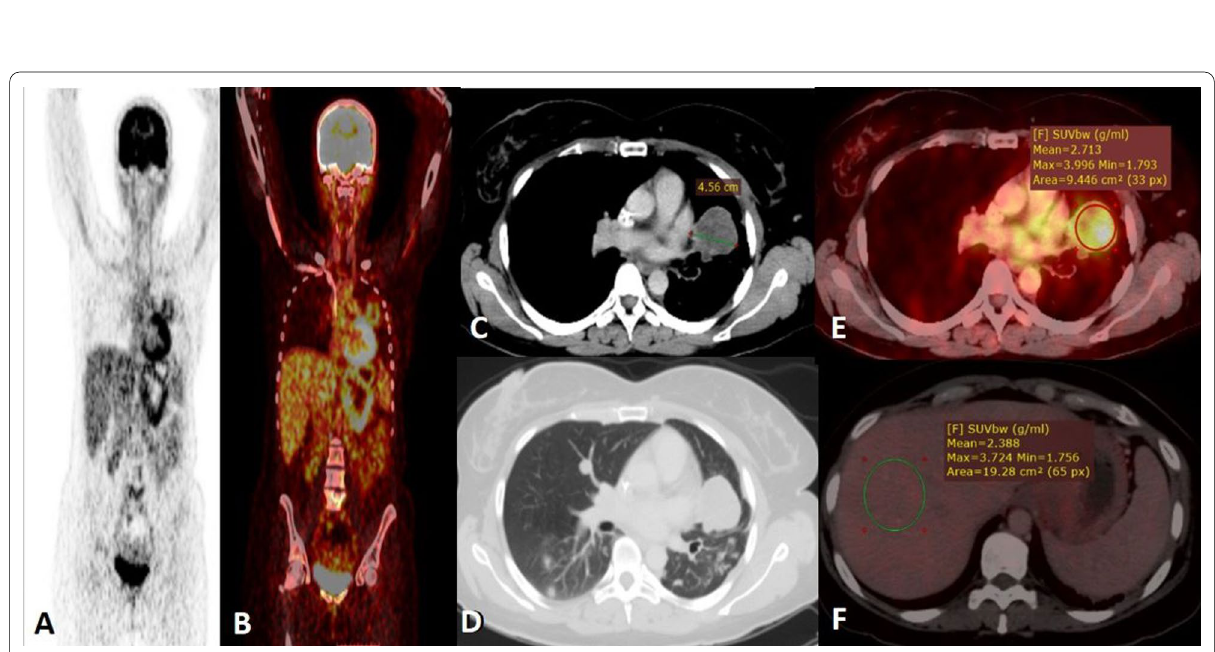
Fig. 3 A 52-year-old female patient proved histopathologically to have adenocarcinoma (AC) involving the left upper lobe. A (coronal PET), B (coronal PET/CT), C (axial CT in a mediastinal window), D (axial CT in a lung window), E and F images (axial PET/CT images). The mass lesion size measured in the C image was 4.56 cm with SUVmax of the tumor was 3.99 as shown in E . TLR was calculated to be 3.99/3.72